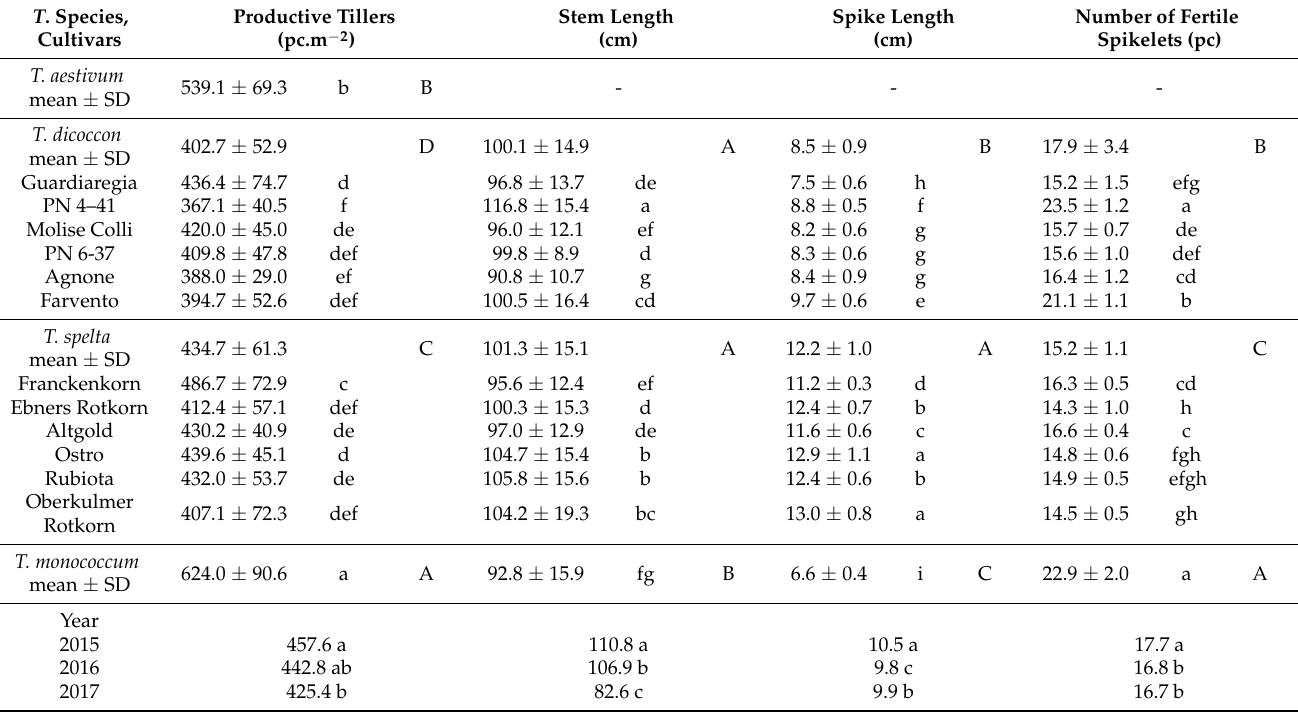
Table 1. Agro-morphological traits of wheat species and